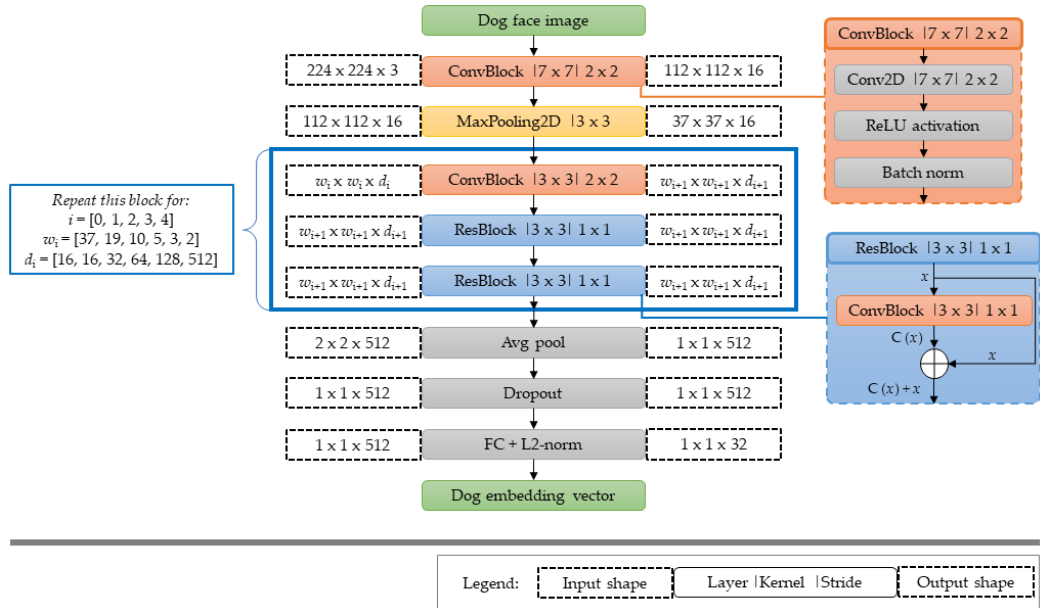
Figure 2. Architecture definition. The architecture takes as input a dog face image of size (224 × 224 × 3) and outputs a 32-dimensional embedding vector for the input image. The repeated block is sequentially repeated 5 times. Descriptions of ConvBlock and ResBlock are shown on the right side of the figure.